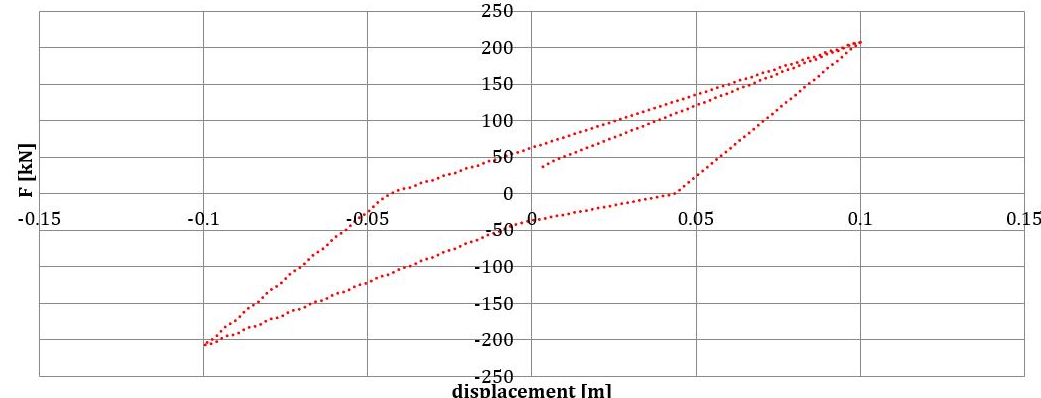
Figure 15. Connection hysteretic behavior. A non-linear time history analysis considering Rayleigh damping has been performed using the seven spectrum-compatible accelerograms reported in Figure 16, obtained using REXEL software [35] by considering the site seismic parameters listed in Ta- ble 2.